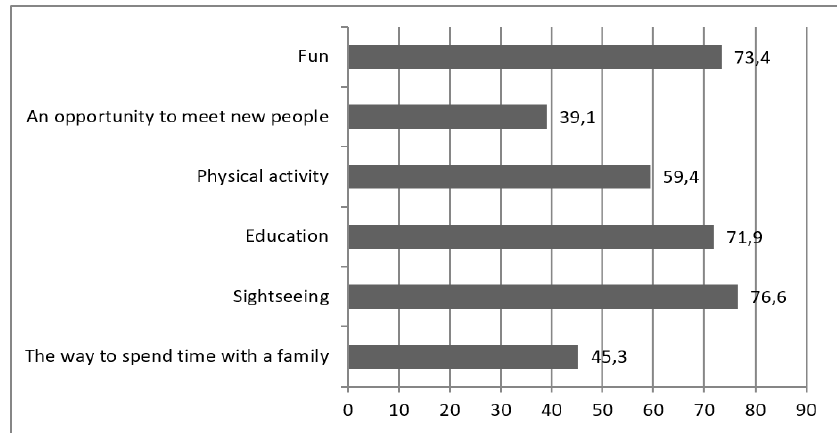
Fig. 4. What do you associate the participation in a quest with? Source: Own study based on the conducted research.